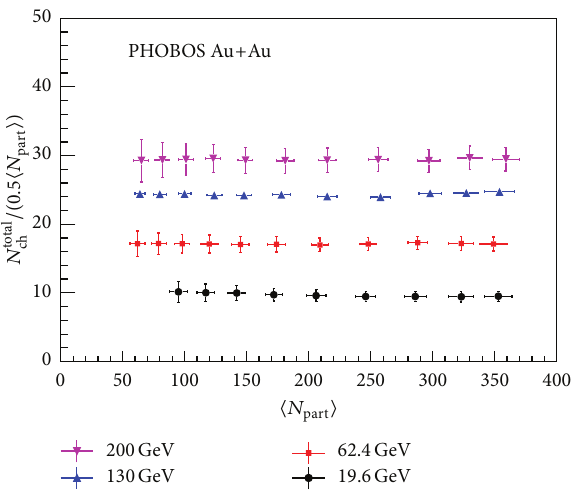
Figure20: 𝑁 total normalizedtoparticipantpairasafunctionof 𝑁 ch for Au+Au collisions at different collision energies.